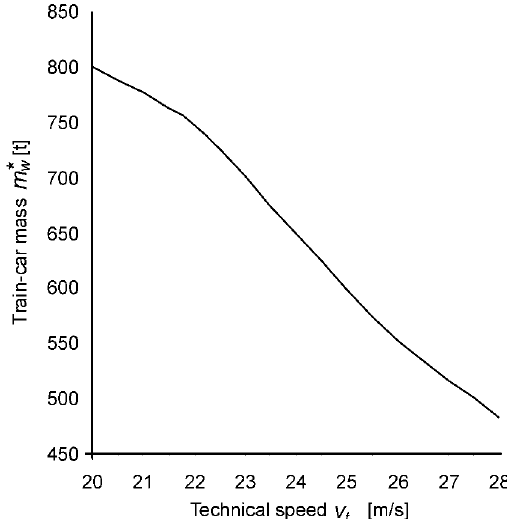
Fig 5. Variation of train-car optimal mass